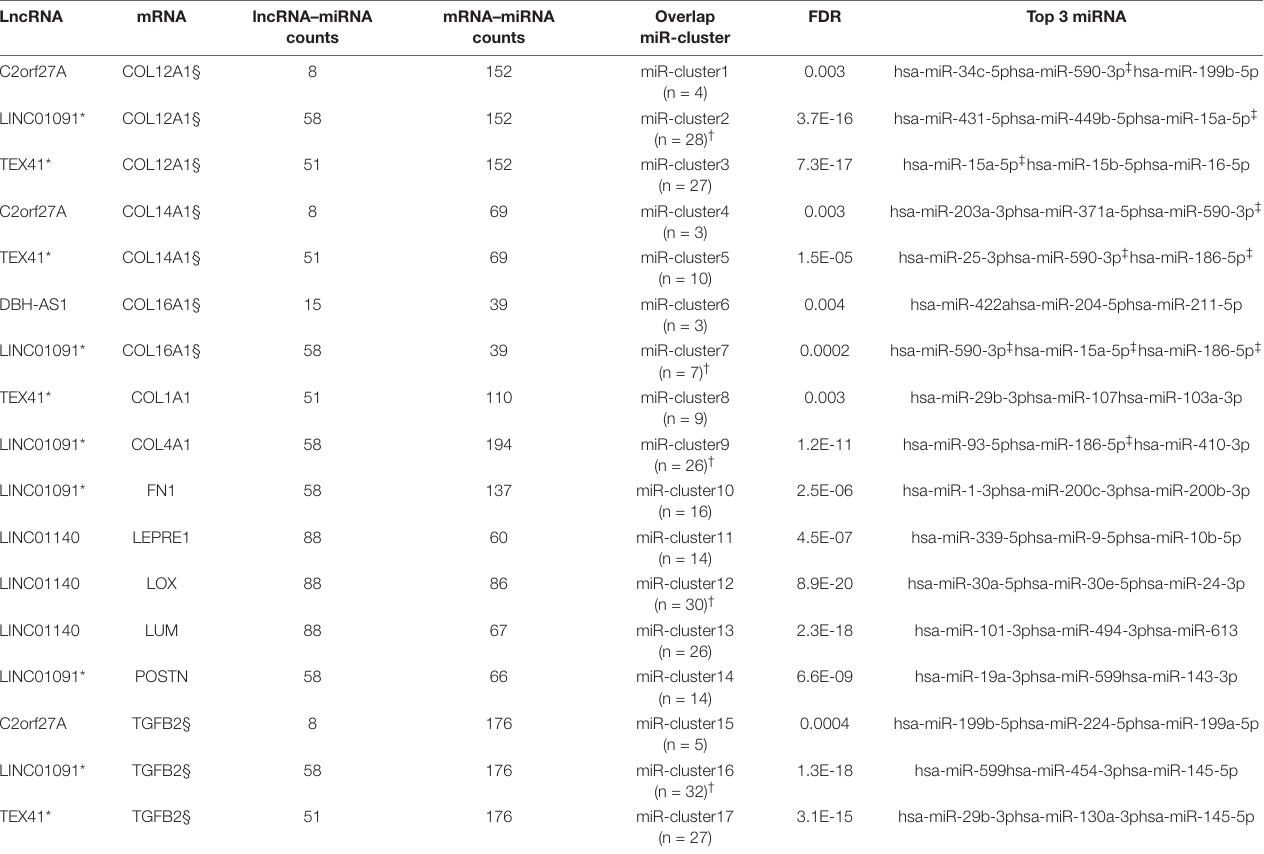
*Top-2 lncRNA ranked by node degrees. § Top-4 mRNA ranked by node degrees. † Top-5 miR-clusters ranked by node degree. ‡ Top-3 miRNA ranked by node degrees. miR-cluster, cluster of overlapped miRNAs; FDR, false discovery rate.